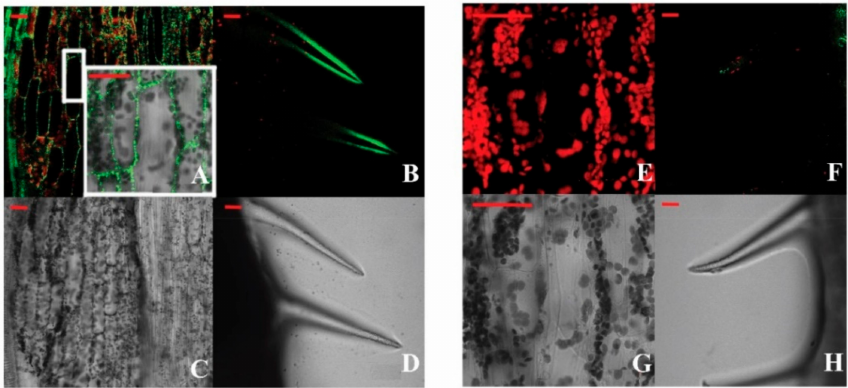
Figure 3. Localization of the fusion protein. ( A – D ): BraLTP2::GFP; and ( E – H ): negative controls. ( A , C , E , G ): B. napus petioles epidermis cells were transformed with construct and visualized with a fluorescence microscope; and ( B , D , F , H ): Trichomes on the leaf apex edge, visualized with a confocal laser scanning microscopy system. Scale bars = 50 µ m.